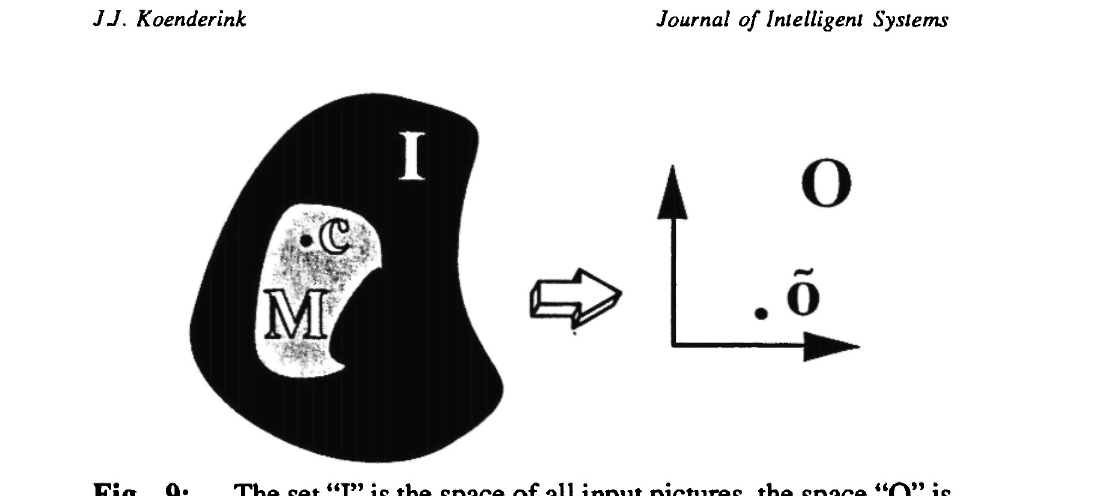
Fig. 9: The set "I" is the space of all input pictures, the space "O" is the space of all possible observations. Given an observa- tion δ, the possible input pictures are a set "M" of meta- meres. One instantiation ("c") can be pointed out as "cano- nical" and thus representative of all metameres. Taylor series of the blurred irradiance at the fiducial location. Another way to put it is that the observation doesn't discriminate between pictures that (when blurred to inner scale s) agree in all mixed partial derivatives up to the n^-order. Again, the observation O '(P) represents the equivalence n class of irradiances that agree in their truncated Taylor series (order n) of the blurred (inner scale s ) irradi- ance at the fiducial location